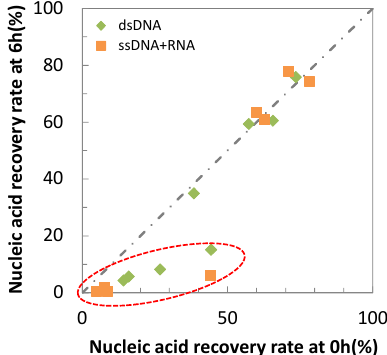
Figure 2. Correlation of nucleic acid recovery rates at 0 h and 6 h. The dotted line indicates nucleic acid recovery rate at 0 h equals to that at 6 h (y = x). Dashed circle indicates the results of copper and its alloys.